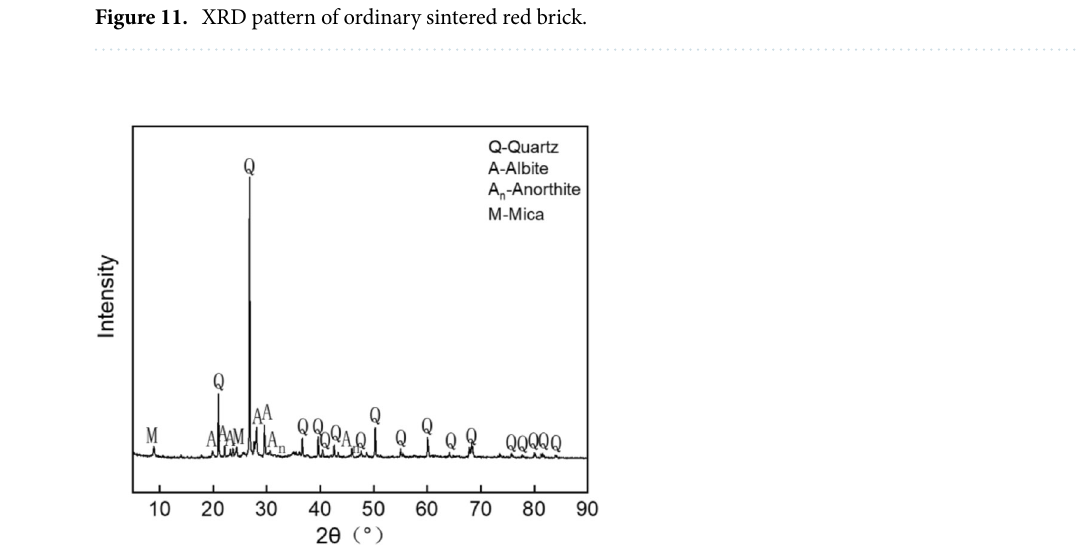
Figure 12. XRD pattern of clay blue brick